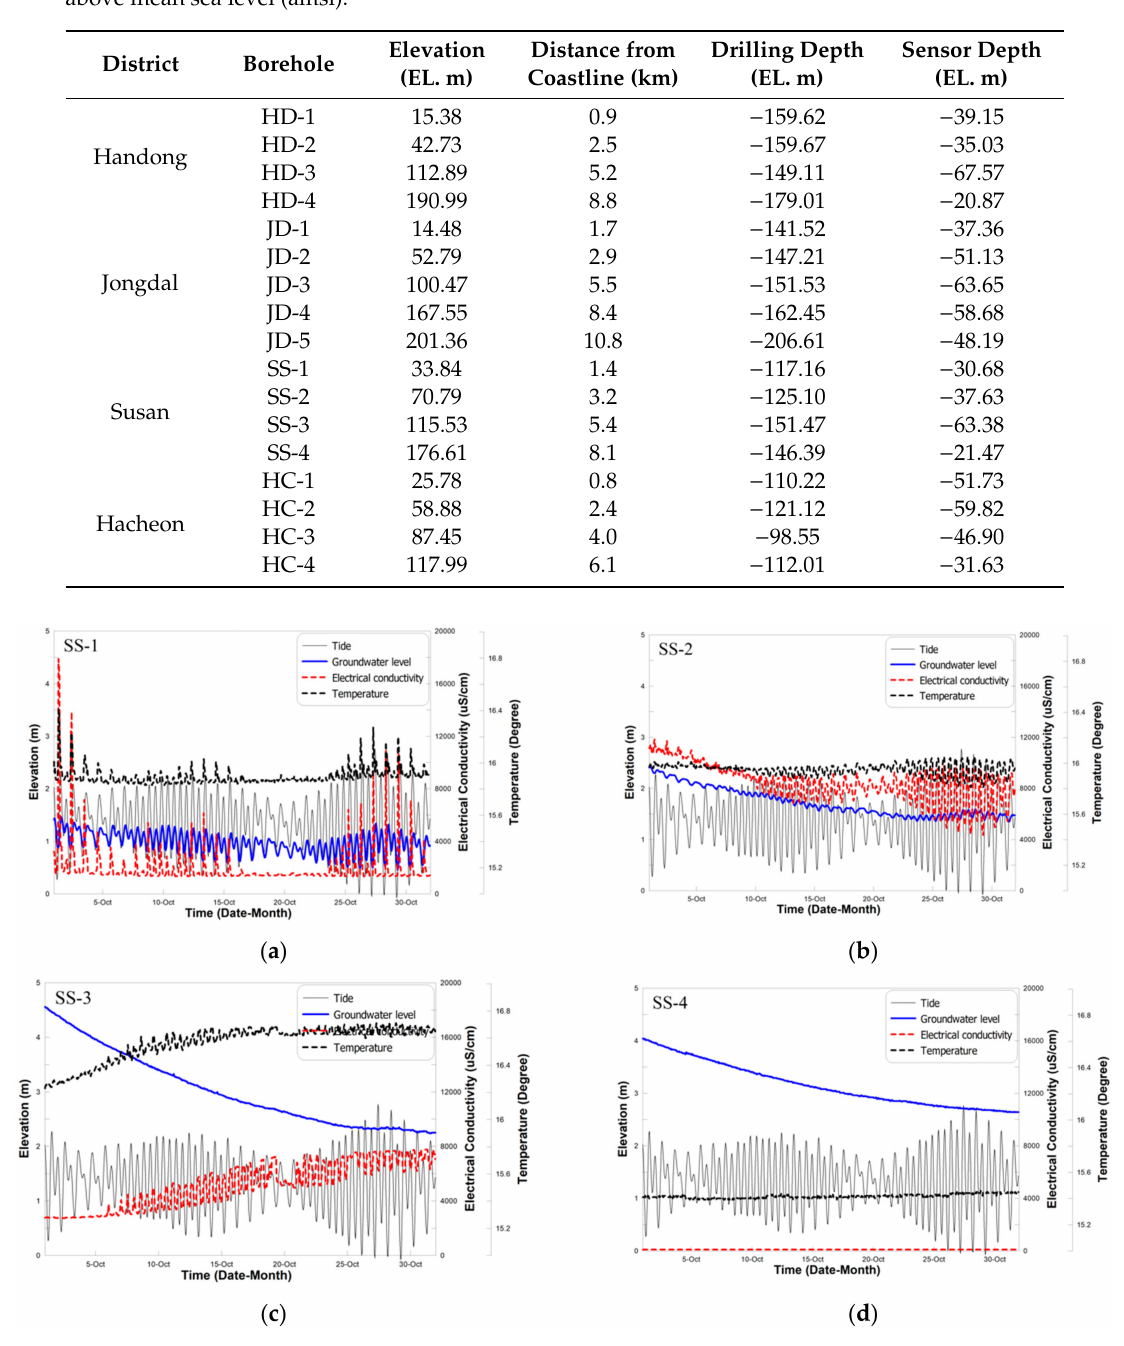
Figure 2. Temporal variation of ocean tide level, groundwater level, electrical conductivity, and temperature in seawater intrusion monitoring wells. Boreholes ( a ) SS-1; ( b ) SS-2; ( c ) SS-3; and ( d )